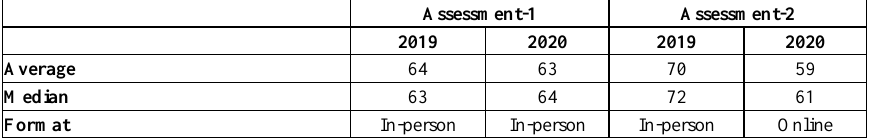
Table 2. Performance of students in the assessments (exams) in Course-B in 2019 and